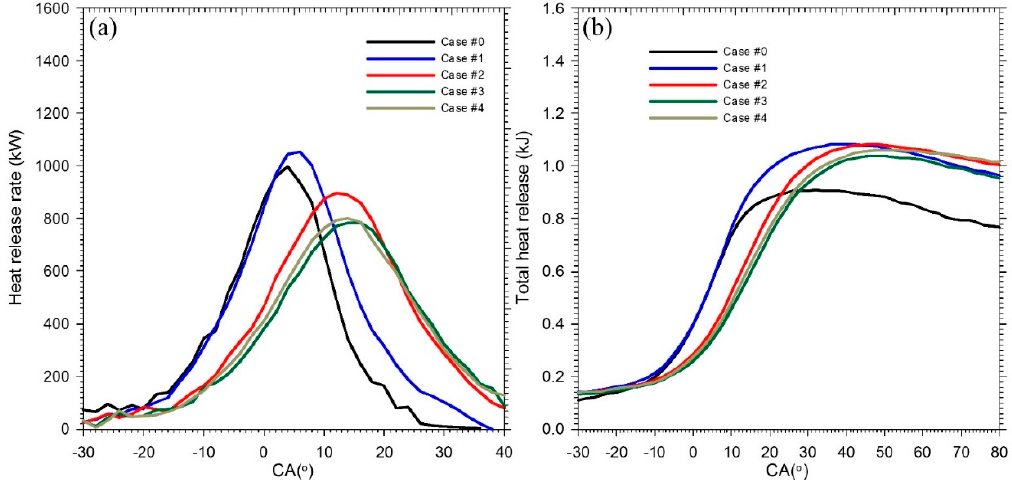
Figure 5. ( a ) Heat release rate; ( b ) Total heat release for different valve settings.